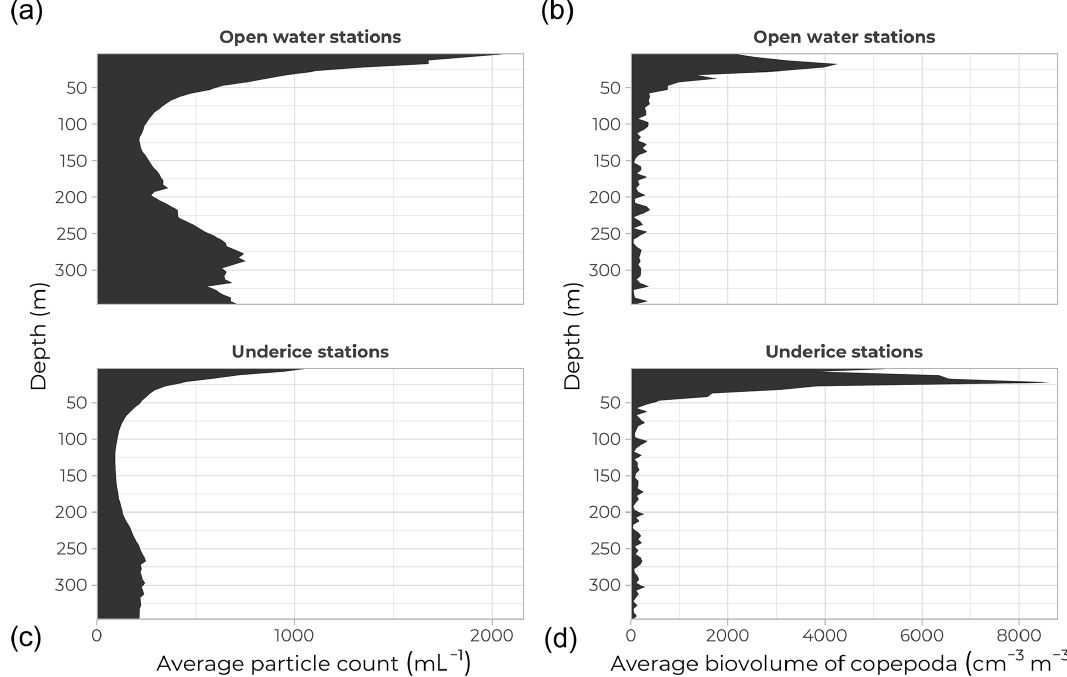
Figure 11. Underwater Vision Profiler data. Average vertical profiles of particle concentration (per mL; a , c ) and copepod volumetric fraction